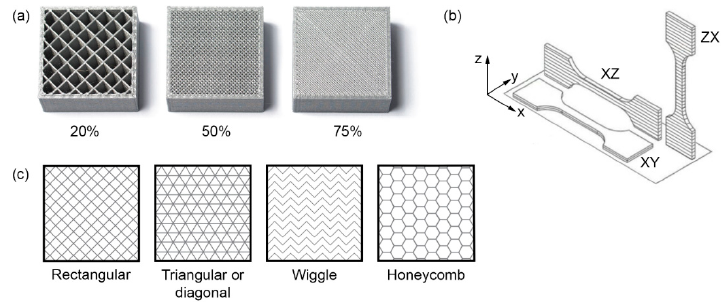
Figure 2. Examples of ( a ) infill percentage, ( b ) build orientation and ( c ) infill pattern.